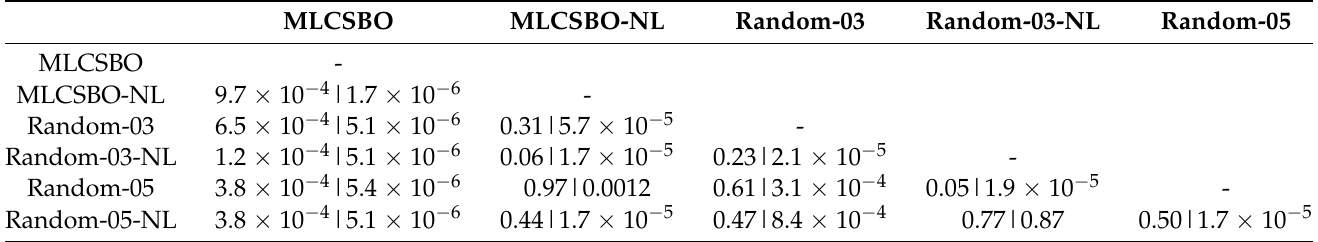
Table 5. Best|average p -values for the Wilcoxon